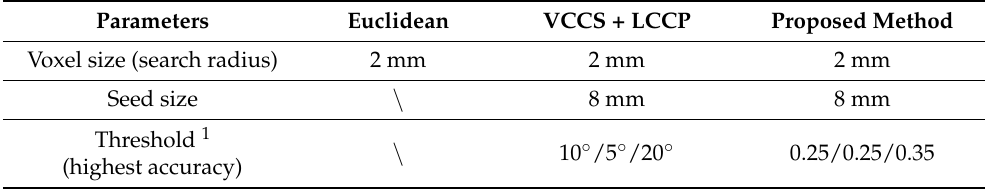
Table 2. The parameters of methods.